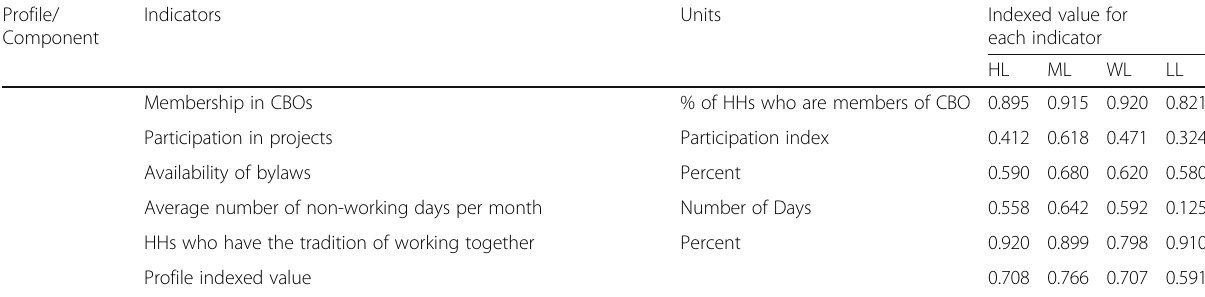
Table 2 Indexed indicators, profiles, and overall LVI for highland, midland, wetland, and lowland AESs (Continued) Profile/ Component